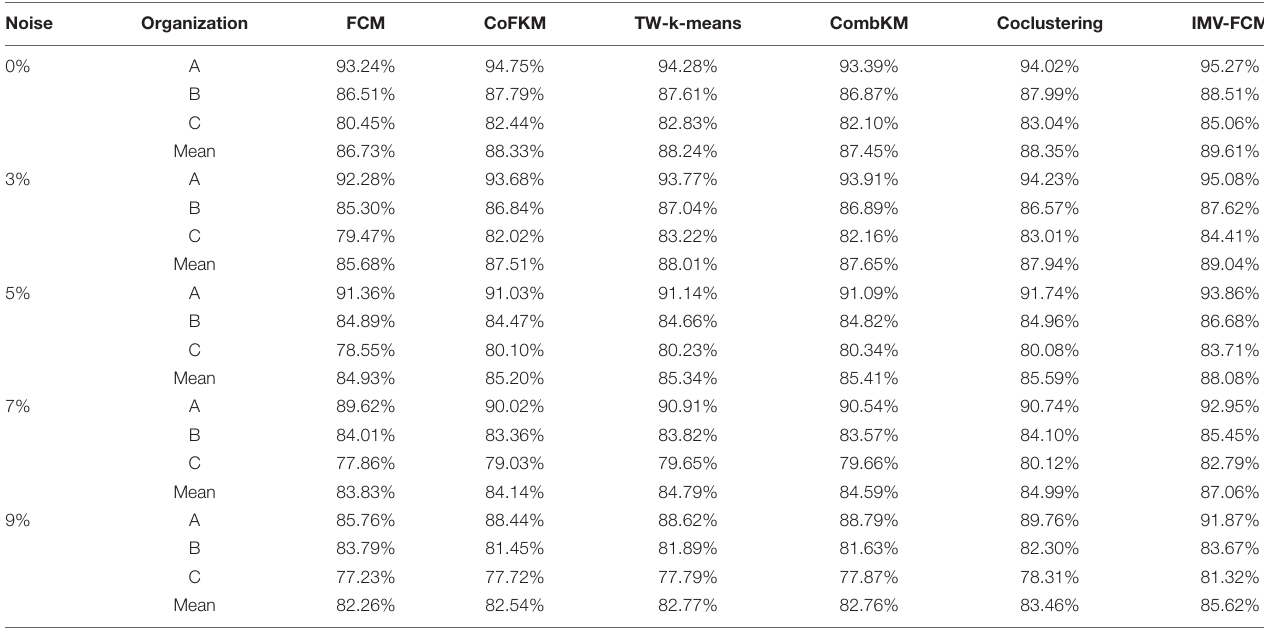
TABLE 9 | DSC indicators of each algorithm (100%).